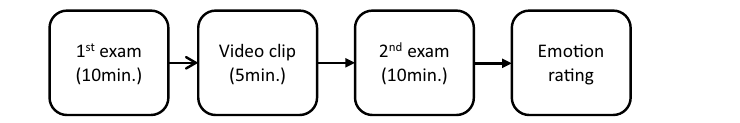
Fig. 1 The procedure of the experiment. The participants completed the first exam in 10 min, watched the video clip for 5 min, and took the second exam in 10 min. Lastly, they rated the intensity of respect and admiration toward the lecturer and the interviewer in the video